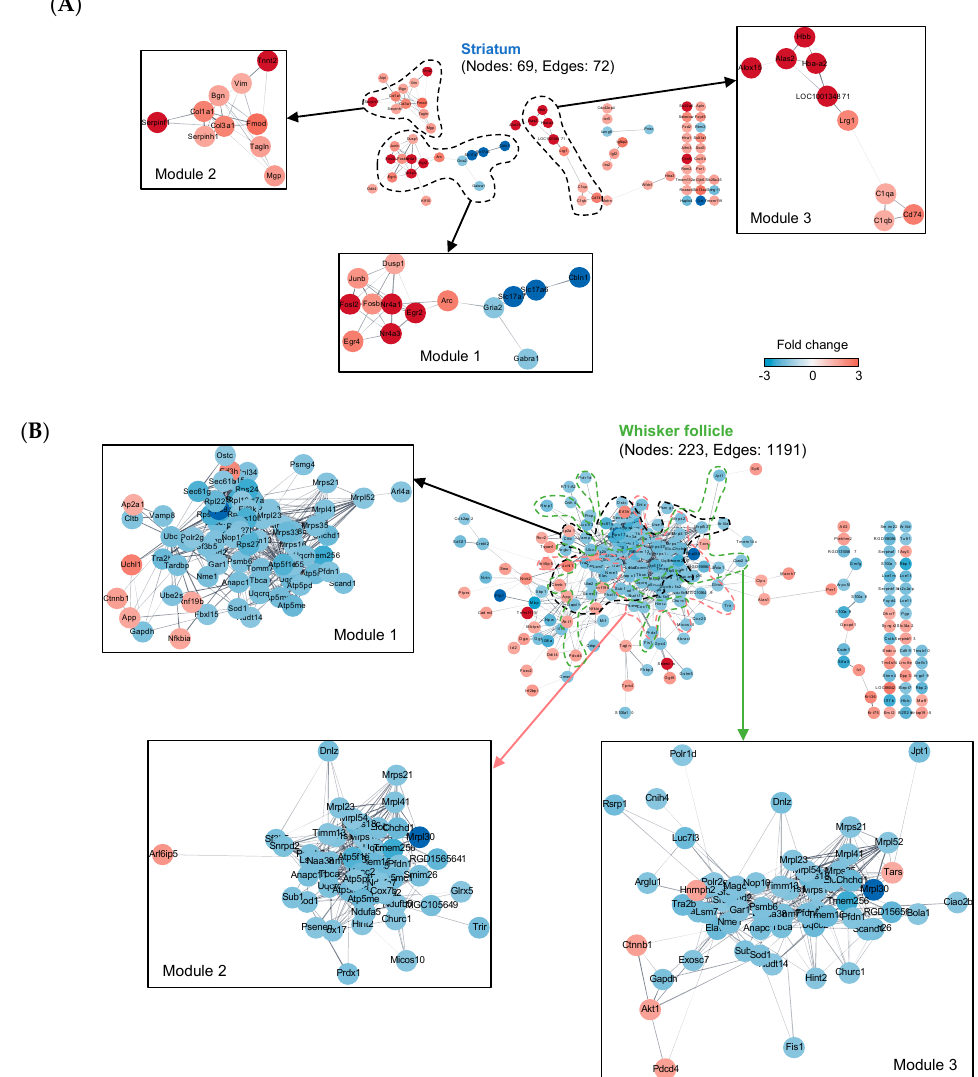
Figure 4. Construction of protein–protein interaction networks (PPI) from DEGs. ( A ) Construction of a PPI network in the striatum. ( B ) Construction of a PPI network in the whisker follicle. The putative PPI networks of DEGs were visualized via the Search Tool for the Retrieval of Interacting Genes/Proteins (STRING) application (confidence (score) cut-off = 0.4) in the Cytoscape software (v3.7.1). Red nodes denote up-regulated genes, and blue nodes indicate down-regulated genes. The intensity of each node color means the fold change. The top three modules of each tissue were identified by the MCODE plug-in in the Cytoscape software.